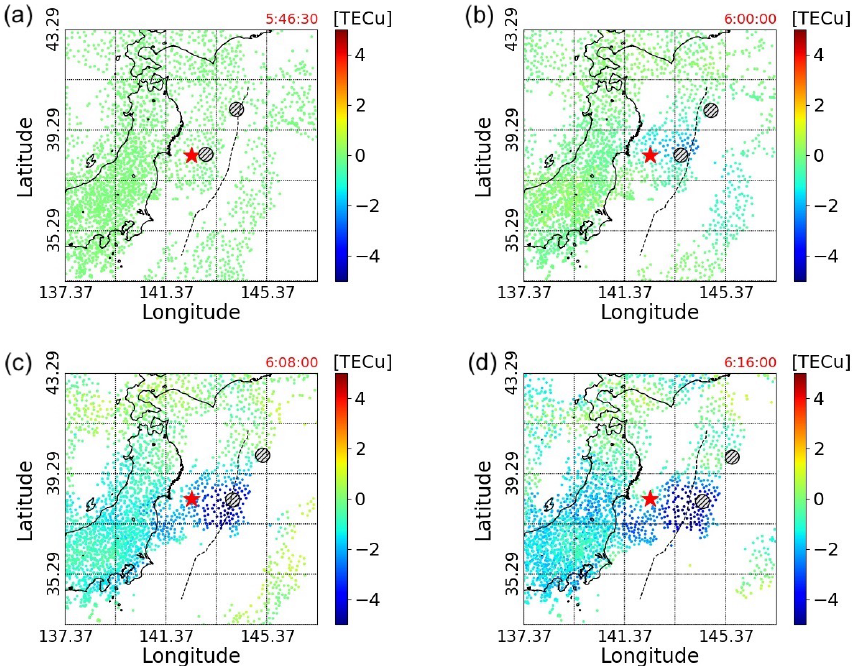
Figure 3. The red star is the epicenter, and the two large black circles are the outliers. Panels (a–d) are the TEC data measured by the GNSS network at 05:46:30, 06:00:00, 06:08:00, and 06:16:00 (UTC), respectively; 05:46:30 was the time of the earthquake occurrence. The black dashed line indicates the location of the axis of the Japan